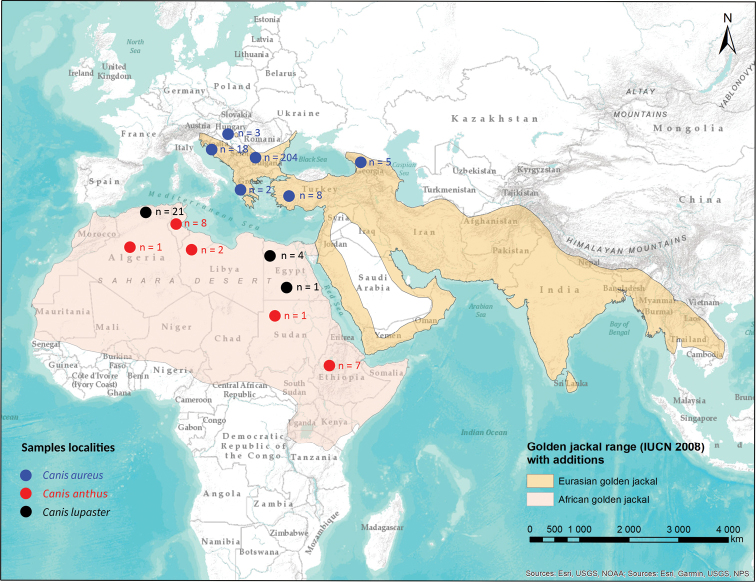
Map of Eurasian golden jackal range (Hoffmann et al. 2018) and African wolf range (Hoffmann and Atickem 2019) based on IUCN Red List data. Sample localities (countries) and number of measured specimens are shown. Note: The range map of Eurasian golden jackal from IUCN Red List has not been updated since 2008. The confirmed presence of jackals in Poland, Denmark, Netherlands and Baltic countries is not shown.